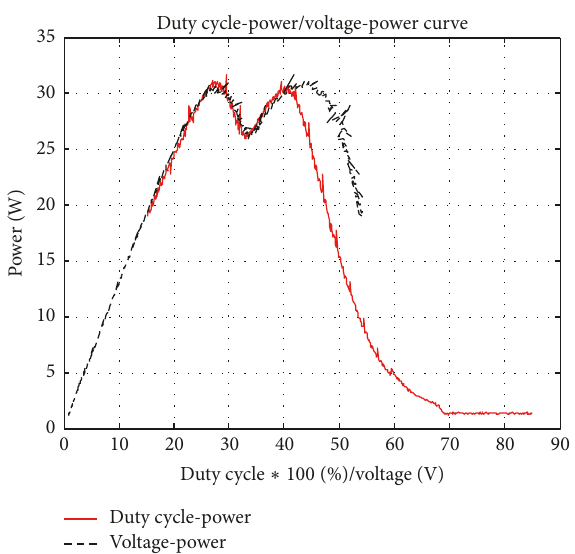
Figure 11: The comparison between D - P and V - P characteristic